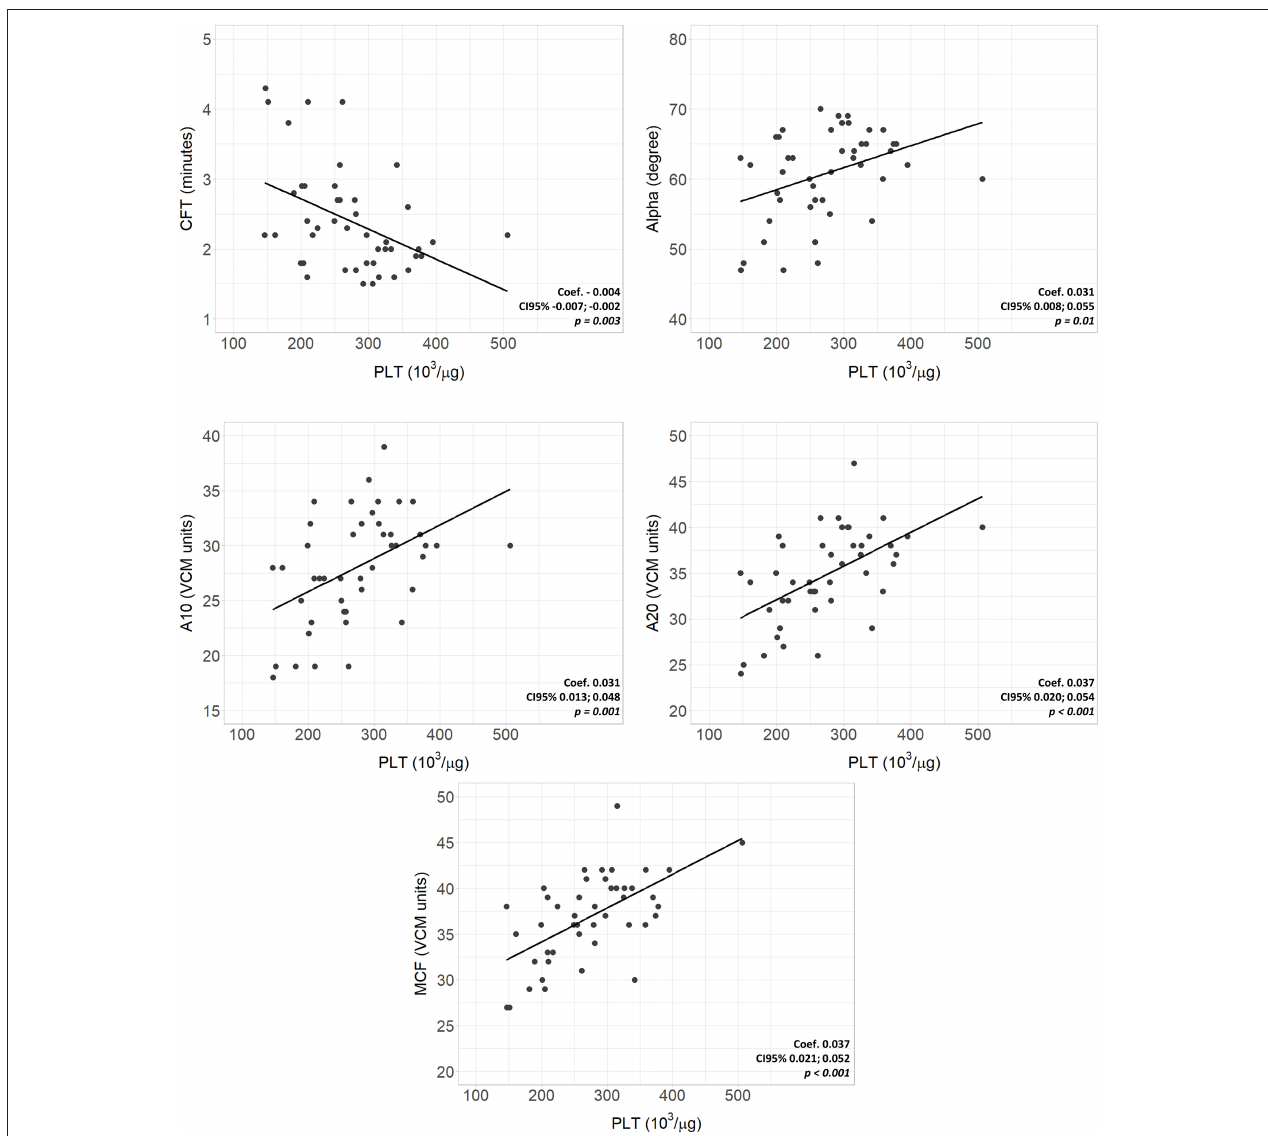
FIGURE 4 | Scatterplots of VCM parameters and corresponding laboratory coagulation parameters: Platelets. Coef, linear regression coefficient; p, p-value; PLT, platelets; CFT, clotting formation time; Alpha, alpha angle; A10, amplitude at 10min; A20 amplitude at 20min; MCF, main clotting formation.